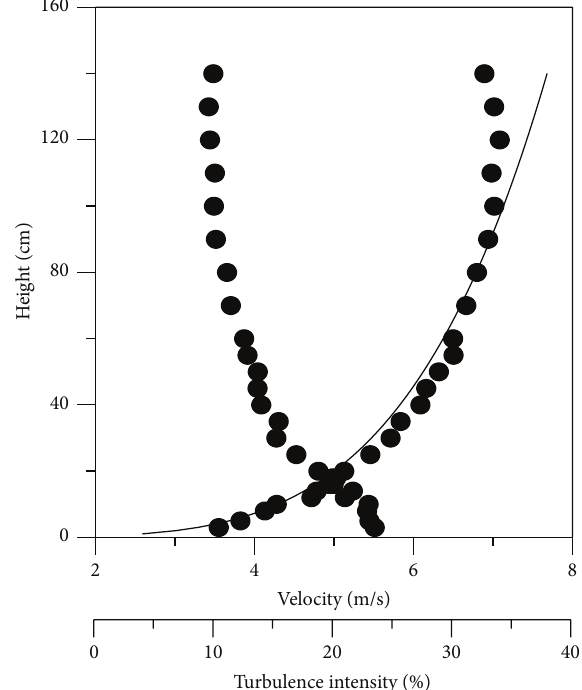
Figure 1: Vertical distribution of mean wind velocities and turbu- lence